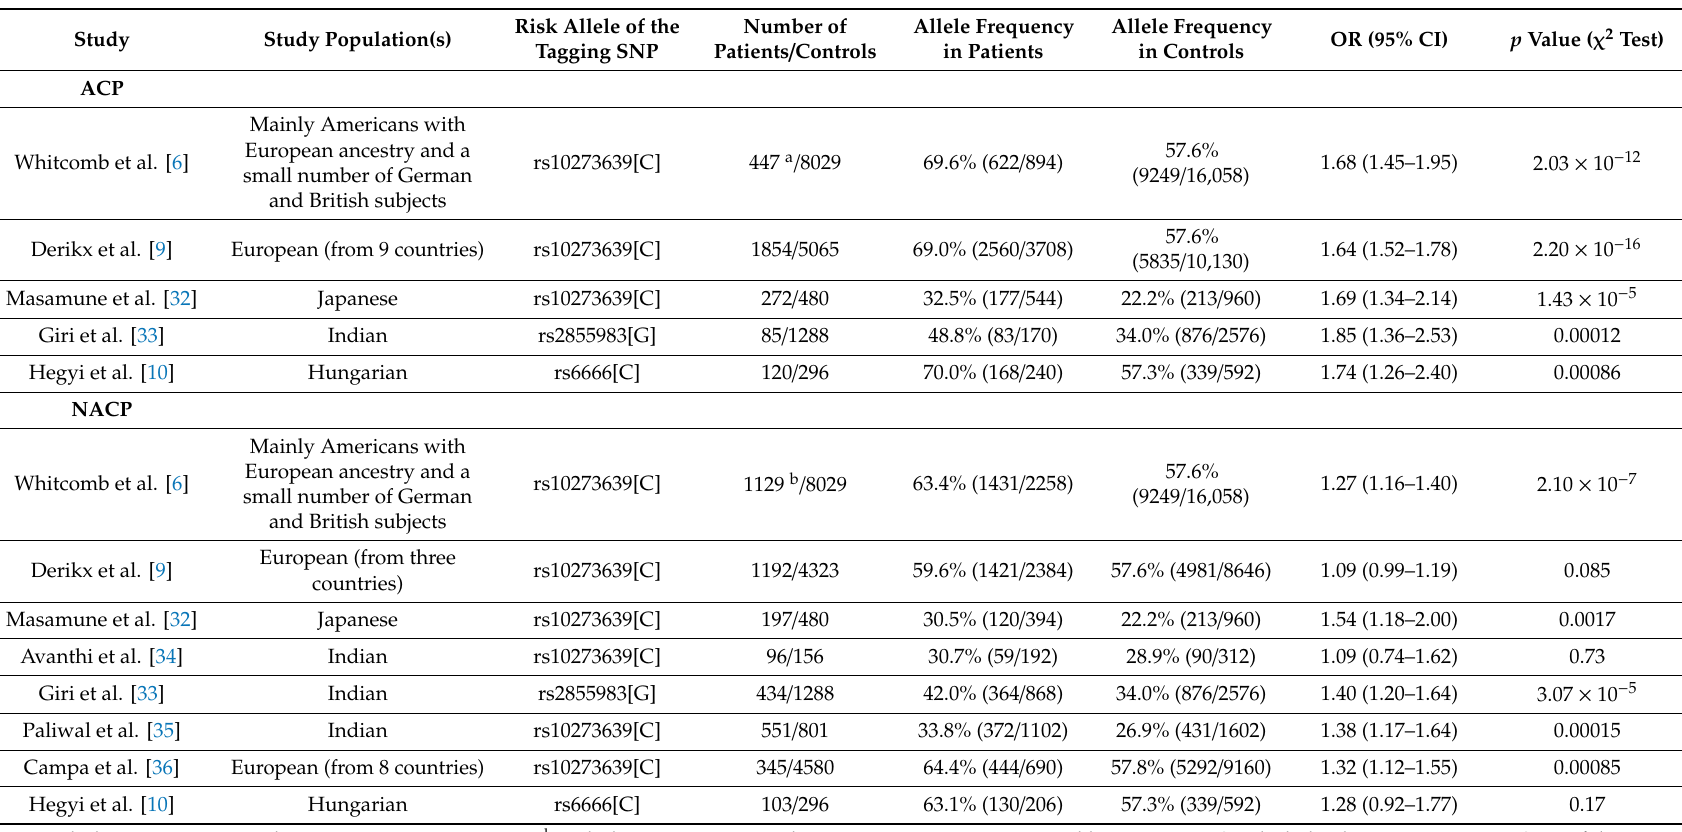
Table 1. Basic characteristics of the included studies and corresponding risk allele frequencies for the common PRSS1 - PRSS2 haplotype-tagging SNPs in patients and